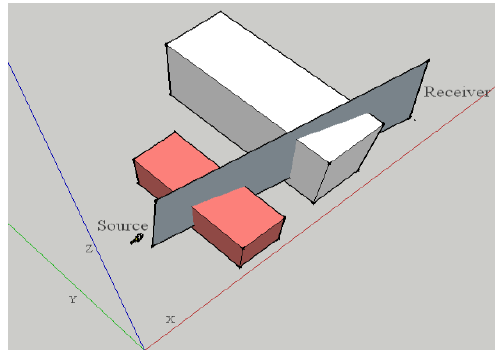
Figure 2. Cutting plane technique of determining potential points for diffraction over top (cutting plane  X-Y plane)